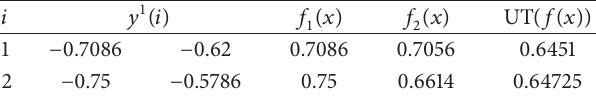
Table 11: The efficient points obtained at the first iteration according to the perturbed reference points.